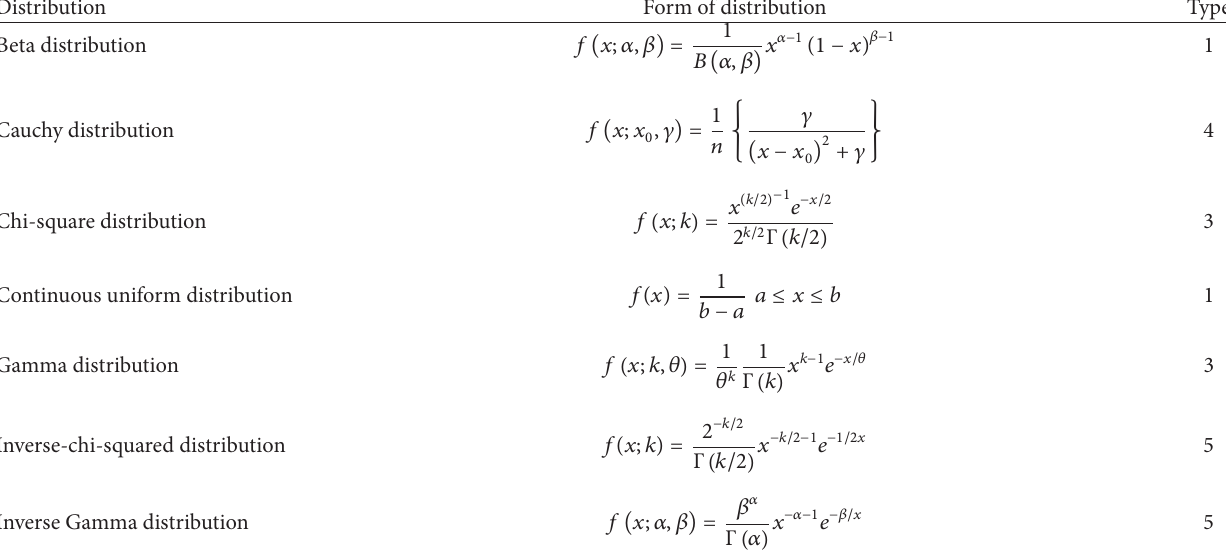
Table 1: The special cases of Pearson